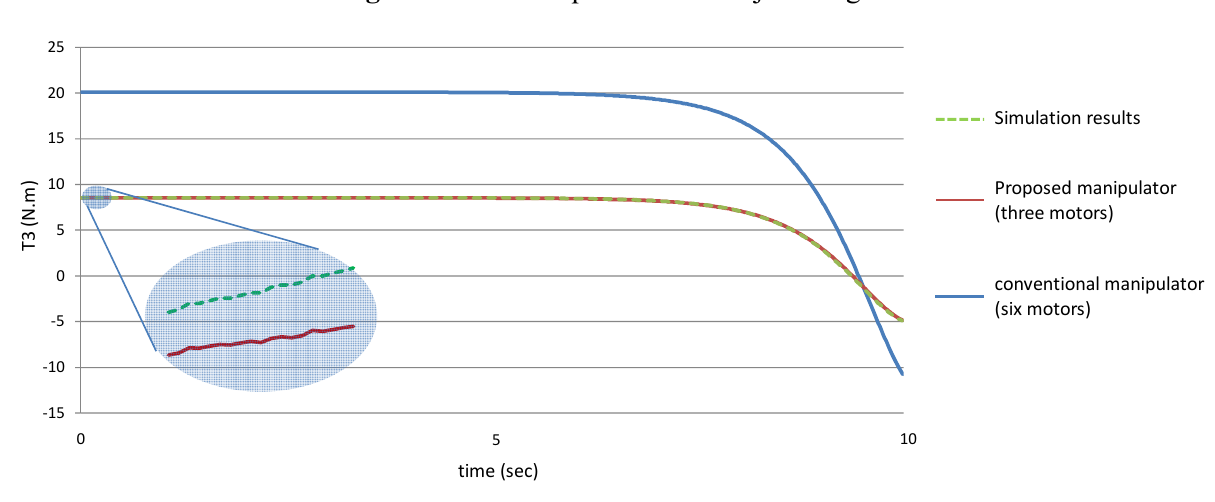
Figure 22. The torque of the third joint angle.